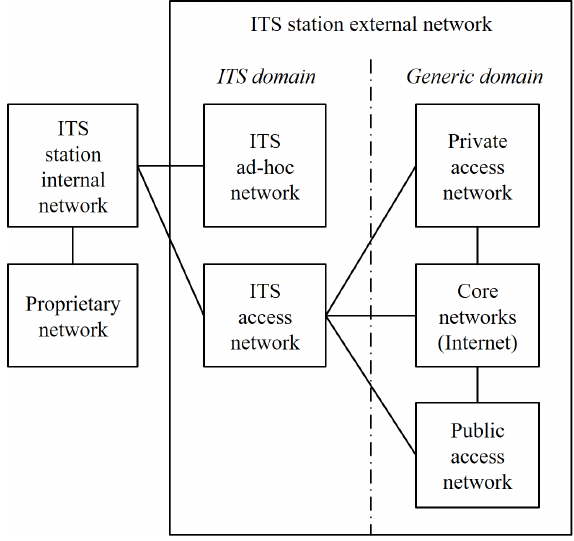
Figure 3. ITS communication